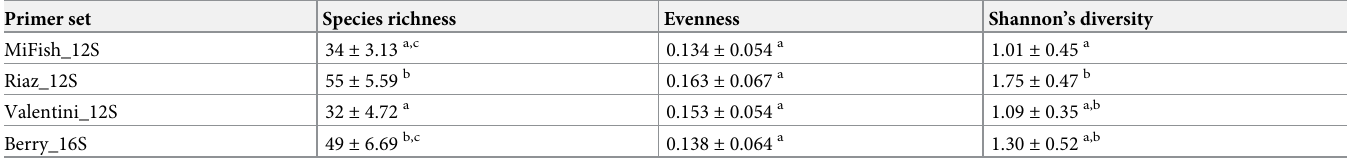
Table 5. Diversity indices including species richness, evenness, and Shannon’s diversity calculated using the R package BiodiversityR v. 2.12–3 for each of the four metabarcoding primer